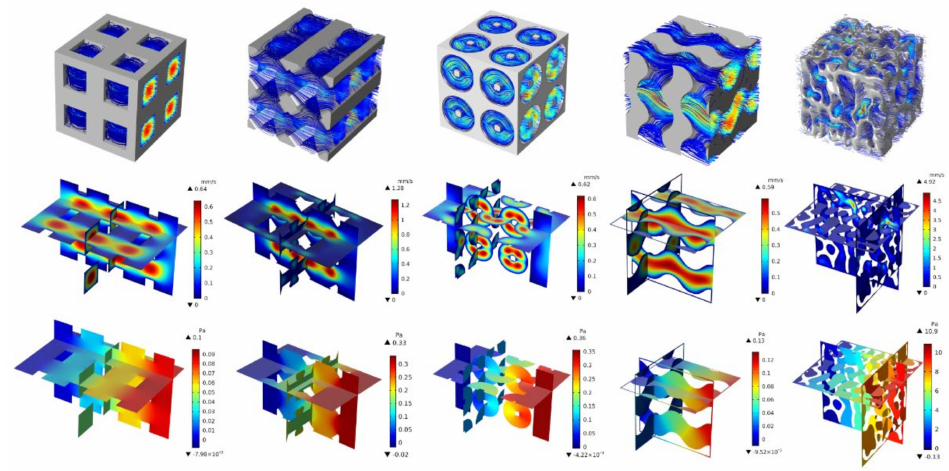
Figure 9. Velocity streamlines, velocity contour, and pressure of porous structure with 60% porosity.